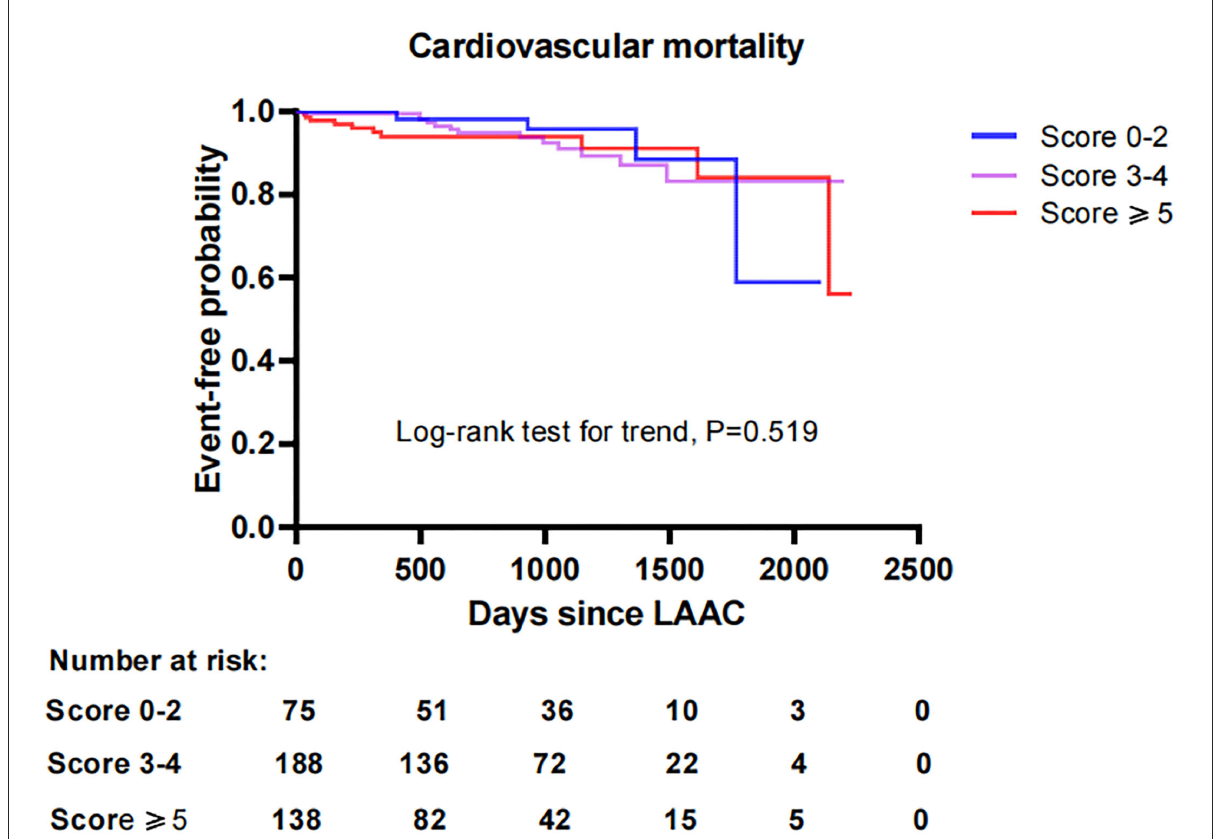
FIGURE2 Comparison of the cumulative ratio of freedom from cardiovascular mortality in different subgroups. LAAC, left atrial appendage